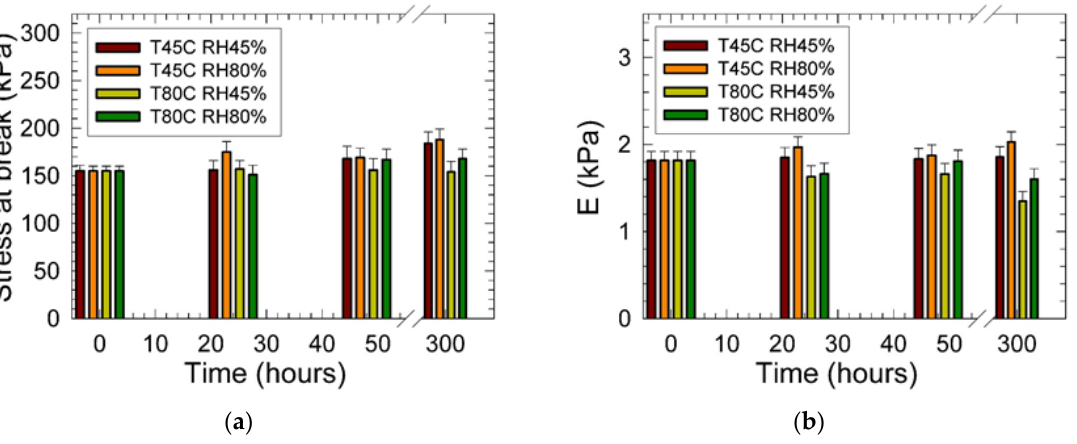
Figure 2. Results of the uniaxial tensile testing of the studied PU materials: ( a ) Stress at break vs. conditioning time at different temperatures and relative humidity; ( b ) Young´s modulus of elasticity ( E ) vs. conditioning time at different temperatures and relative humidity. Inset: T — temperature (°C), RH — relative humidity (%).